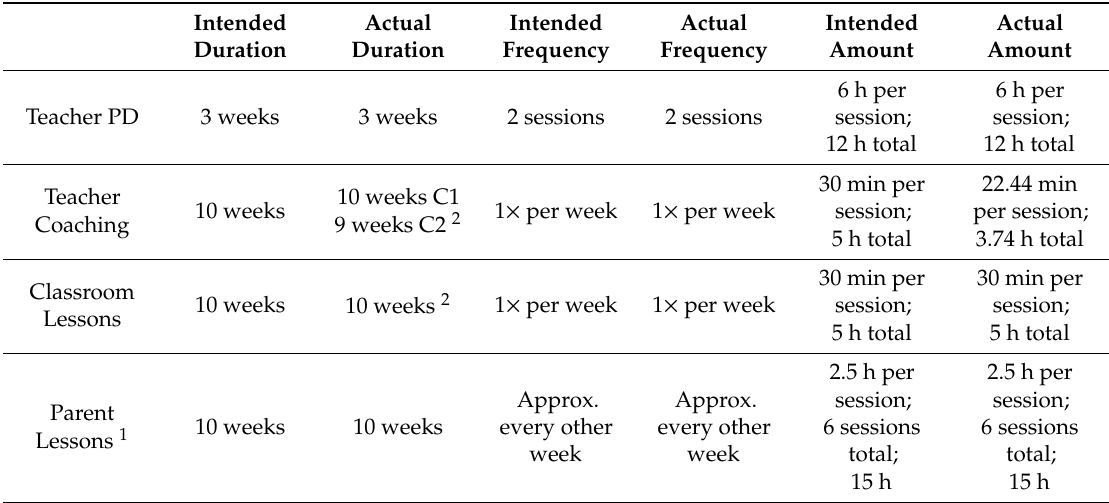
Table 1. Intended / actual duration, frequency, and amount for INSIGHTS.